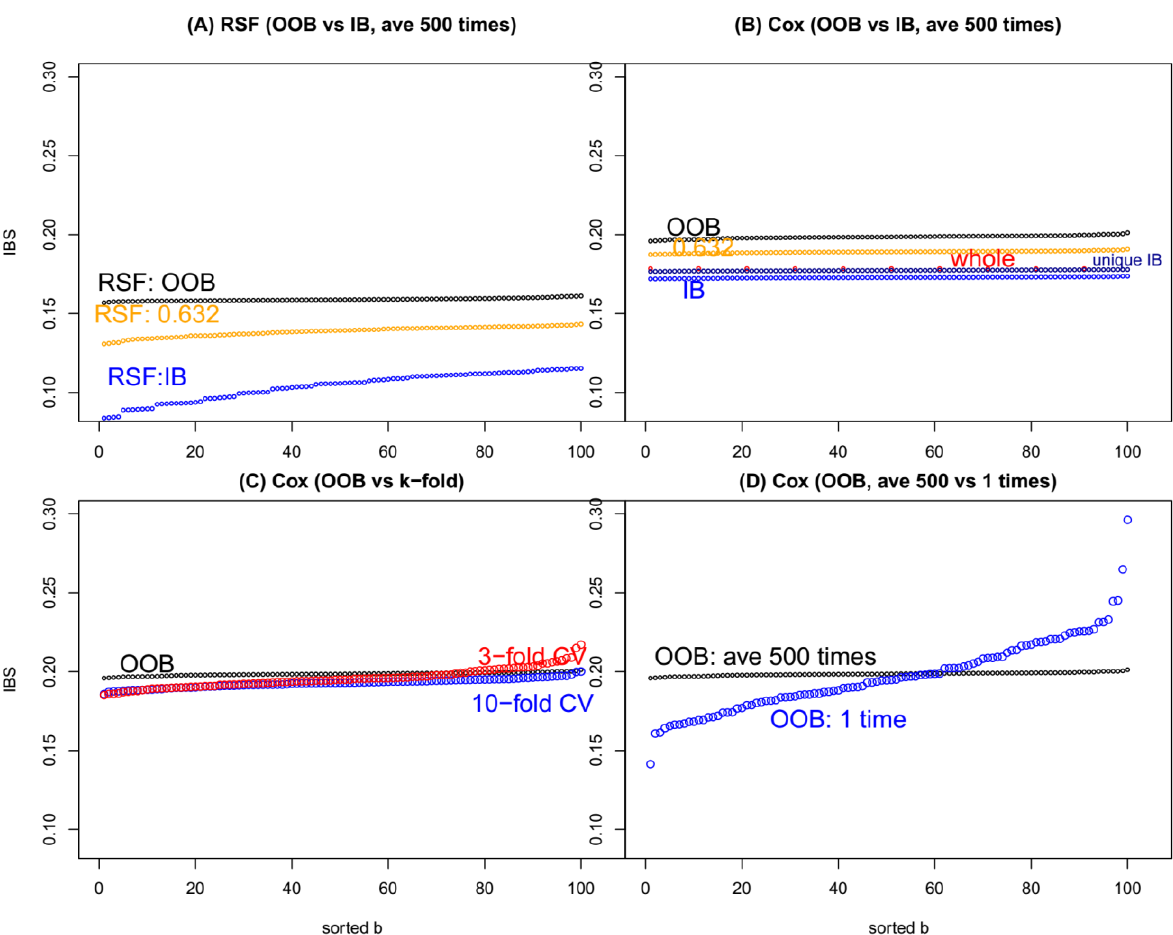
Figure 2. IBS (integrated Brier score) by both Random Survival Forest (RSF) and Cox regression for the colorectal survival dataset in various validation set selections and choice between ensemble or single classifier. (A) RSF: for OOB (black), IB (blue), and weighted of both (0.632 of OOB and 0.368 for IB) (orange); (B) Cox regression: for OOB (black), IB (blue), and 0.632-weight (orange), whole dataset as both training and testing (red), unique IB (dark blue); (C) Cox regression: 3-fold CV(red), 10-fold CV(blue); (D) Cox regression: single classifier OOB (blue). The Cox OOB IBS in (B) is reproduced in (C) and (D) for